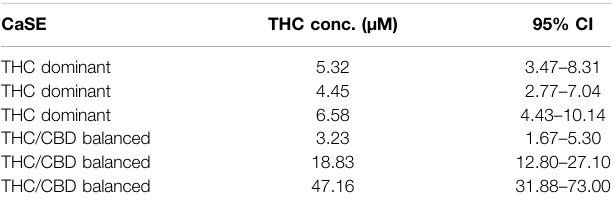
TABLE 4 | Estimation of THC concentrations in 100% CaSE. THC concentrations in CaSE were estimated from interpolation of standard THC concentration response curve in Figure 3 .